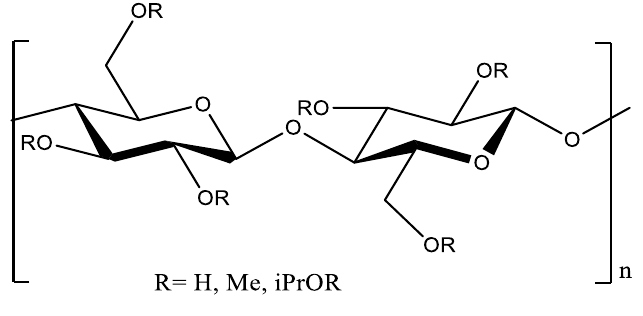
Figure 2. Structure of (HPMC) [60].